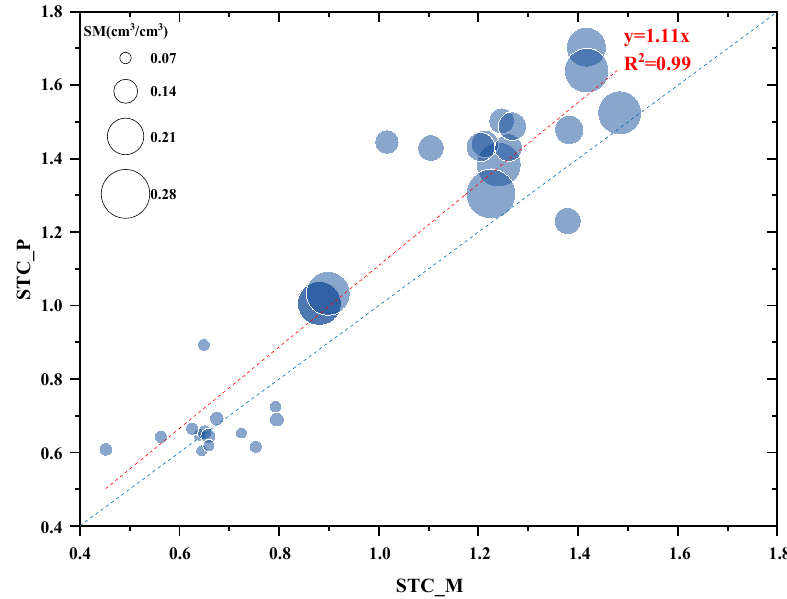
Figure 8. Relation between measured (STC_M) and simulated (STC_P) results.